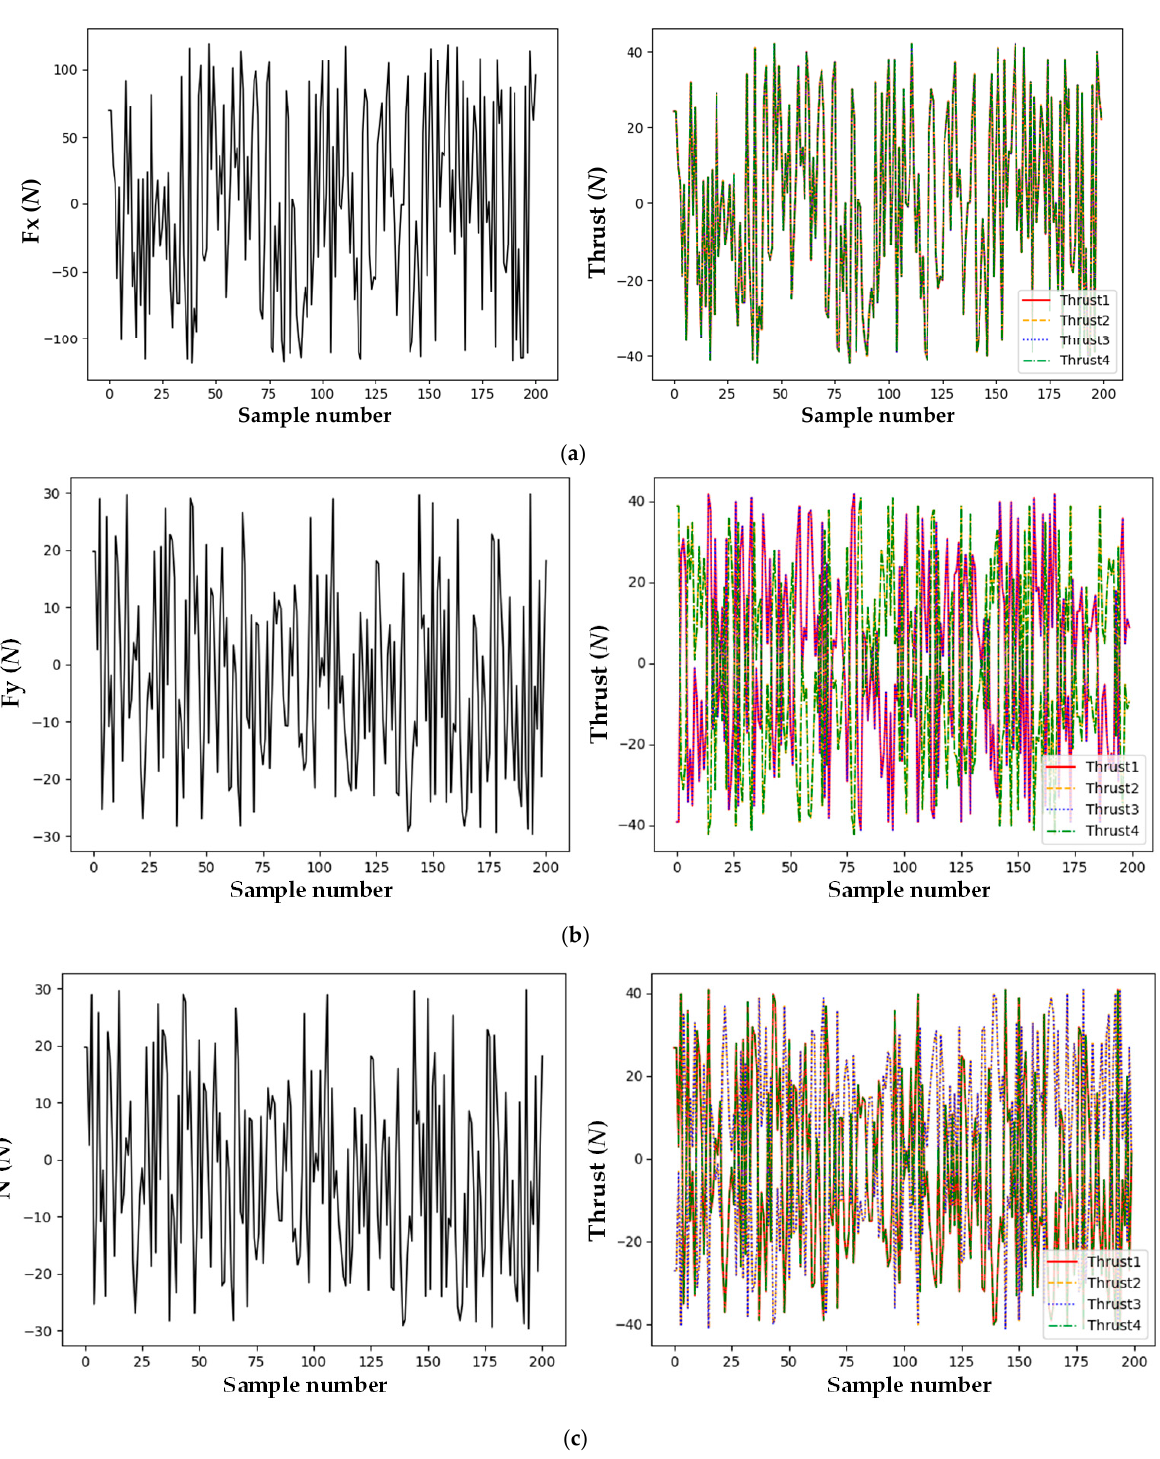
Figure 3. Single degree of freedom thrust distribution result: ( a ) thrust distribution result of surge direction; ( b ) thrust distribution result of sway direction; ( c ) thrust distribution result of yaw direction.